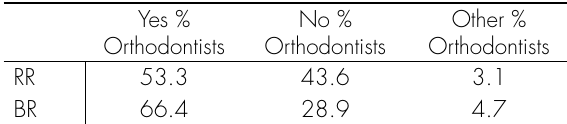
Table VI. ‘Happy for general dental practitioners to continue retainer checks’ by orthodontists.